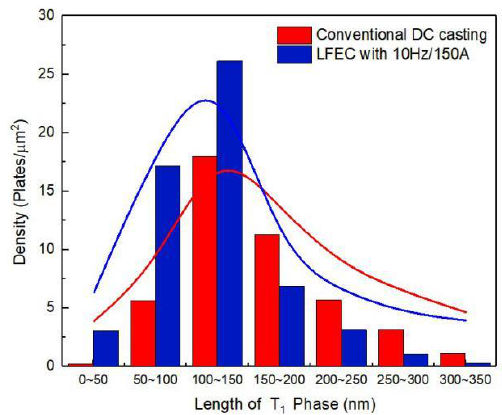
Figure 11. Number density of T 1 of 2A97 alloy after T6 treatment.